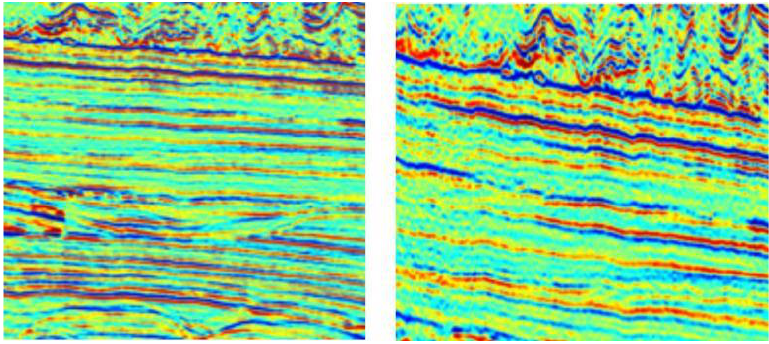
Figure 6. Image of seismic profile classification dataset.